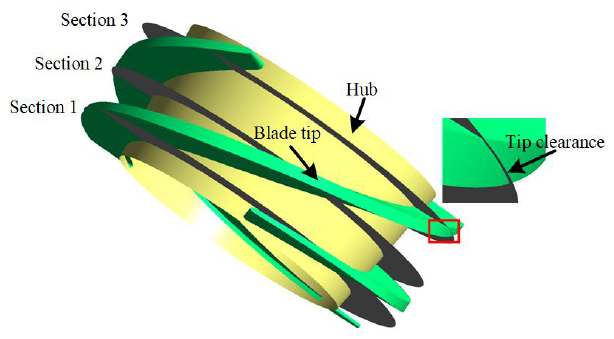
Figure 10. Sections in impeller.